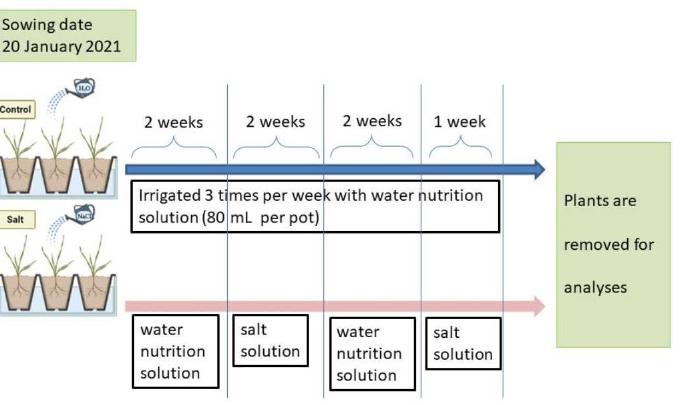
Figure 5. Experimental model, indicating when salt stress was applied by adding NaCl to the water nutrition